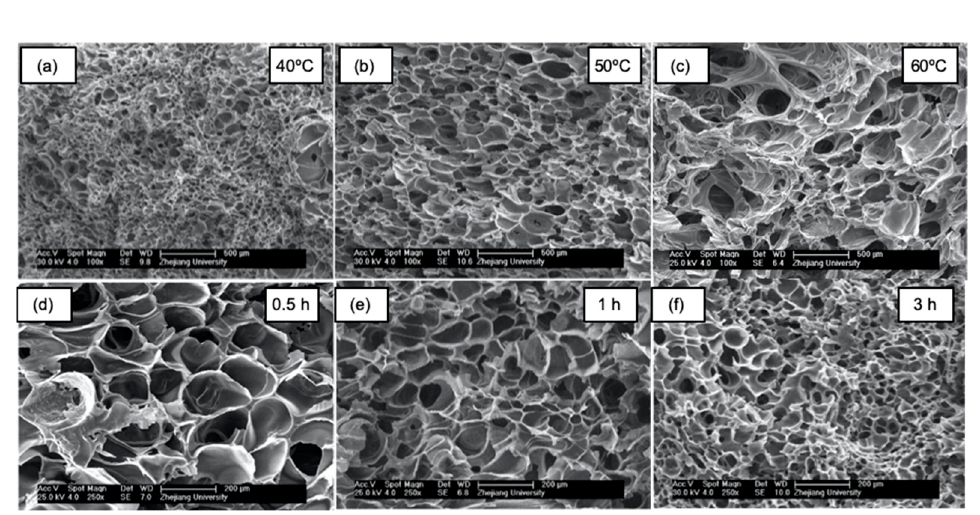
Figure 9. Morphological analysis by SEM imaging of PCL scaffolds processed by supercritical CO 2 foaming at 10 MPa. ( a – c ) At a given soaking time (2 h), increasing the working temperatures induced the formation of larger pores. ( d – f ) Conversely, for a specific foaming temperature (40 °C), longer soaking times render scaffolds displaying smaller pores with greater pore numbers. Figure reprinted from The Journal of Supercritical Fluids, 117, Chen, C.-X., Liu, Q.-Q., Xin, X., Guan, Y.-X., and Yao, S.-